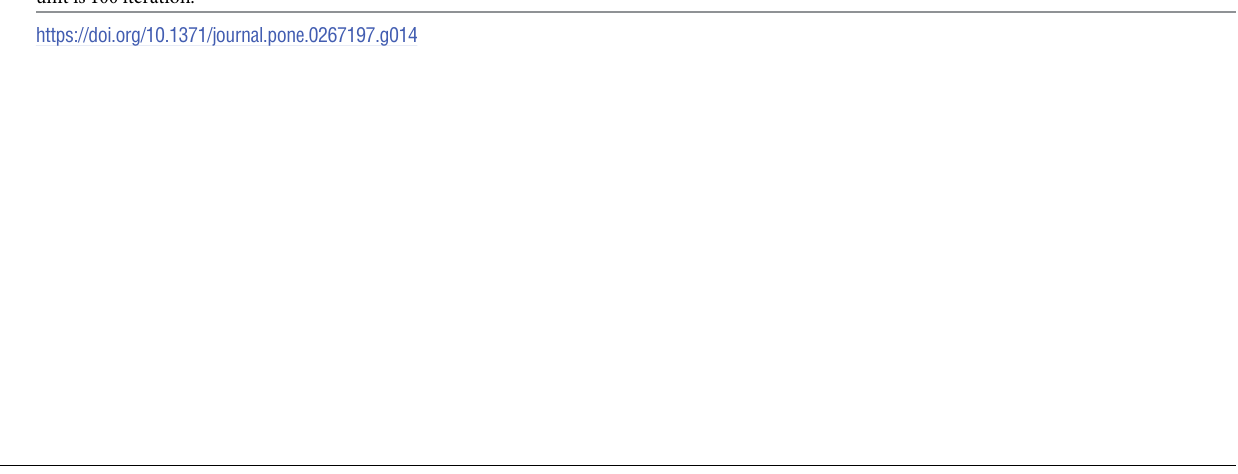
PLOS ONE | https://doi.org/10.1371/journal.pone.0267197 May 2, 2022 18 /